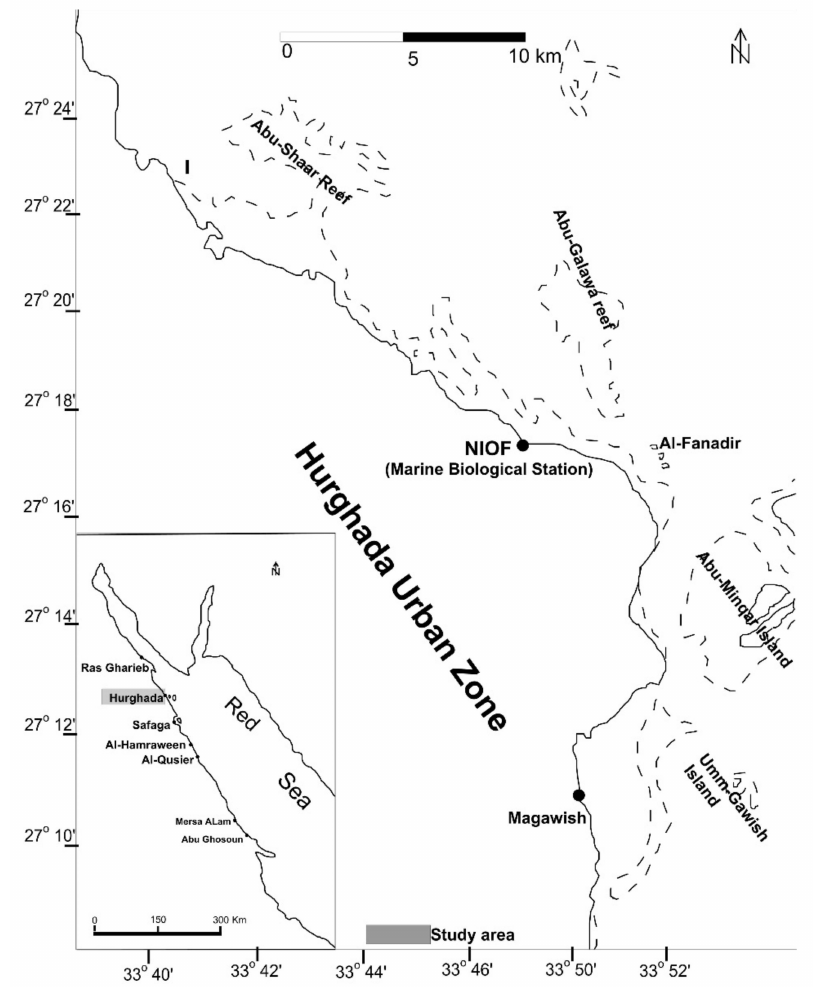
Figure 2. Samples collection